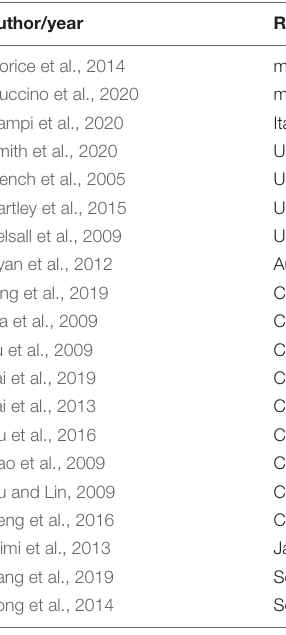
TABLE 1 | Sex distribution of patients with chronic